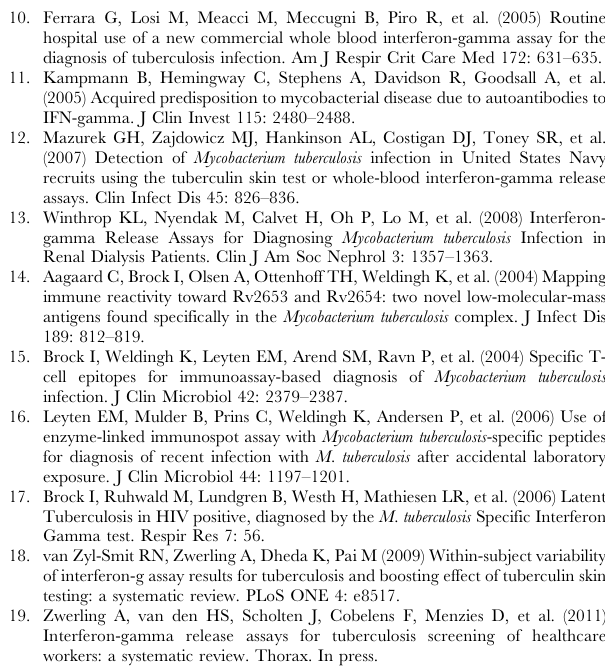
Table S1 Measurements required for one Quanti- FERON-TB Gold test. The QuantiFERON-TB Gold test (QFT-G) requires at least 136 measurements to complete one test. Table S2 Measurements required for one Quanti- FERON-TB Gold In-Tube Test. The QuantiFERON-TB Gold In-Tube test (QFT-GIT) requires at least 126 measurements to complete one